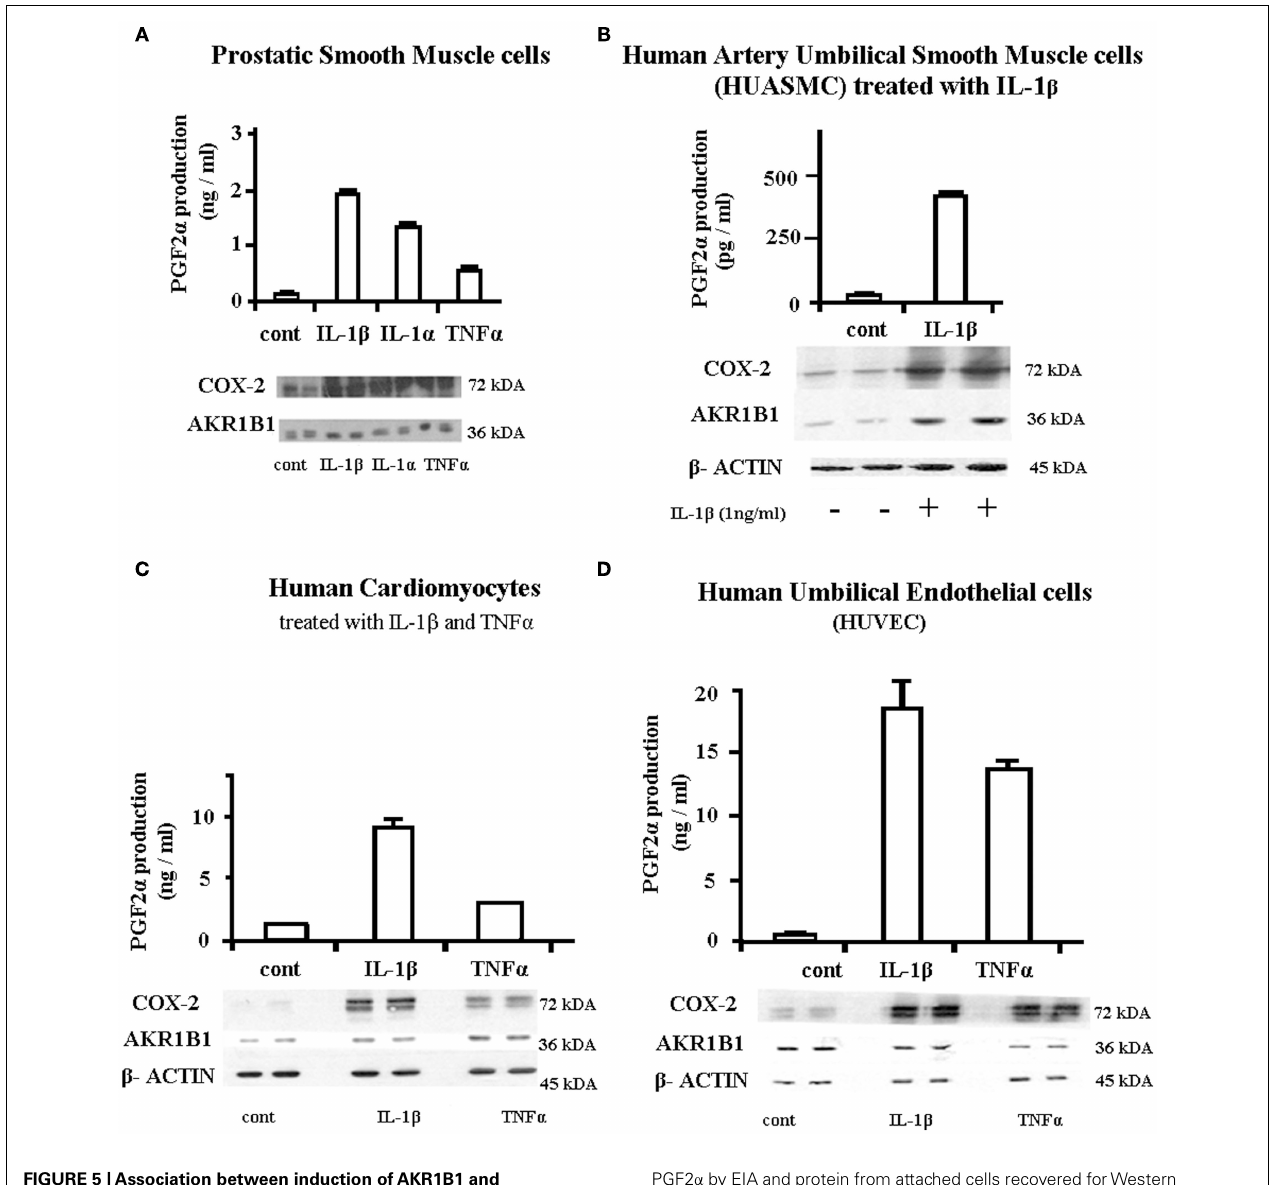
FIGURE 5 |Association between induction ofAKR1B1 and PGF2 α production following cytokine stimulations in cells from different human tissues. Cells from different human tissues were grown to confluence and treated with IL-1 β or IL-1 α 1ng/ml orTNF α at 10ng/ml for 24h.The culture medium was recovered for assay of